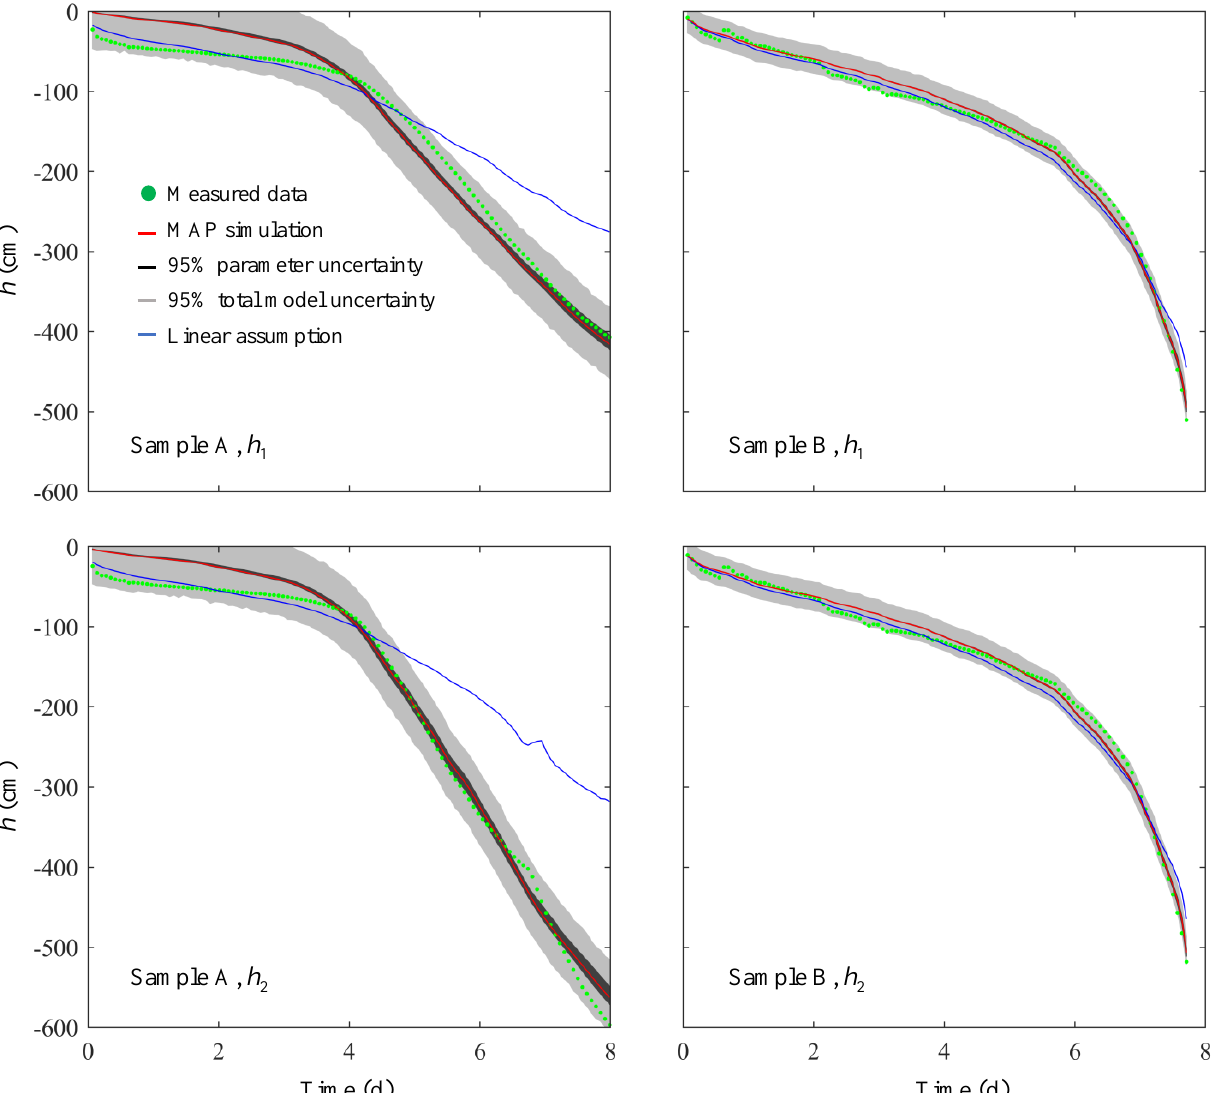
Figure 10. Reproduced pressure head variations over time. The 95% confident interval around the MAP curve was determined from posterior parameters (dark grey zone) or the total model prediction (light grey